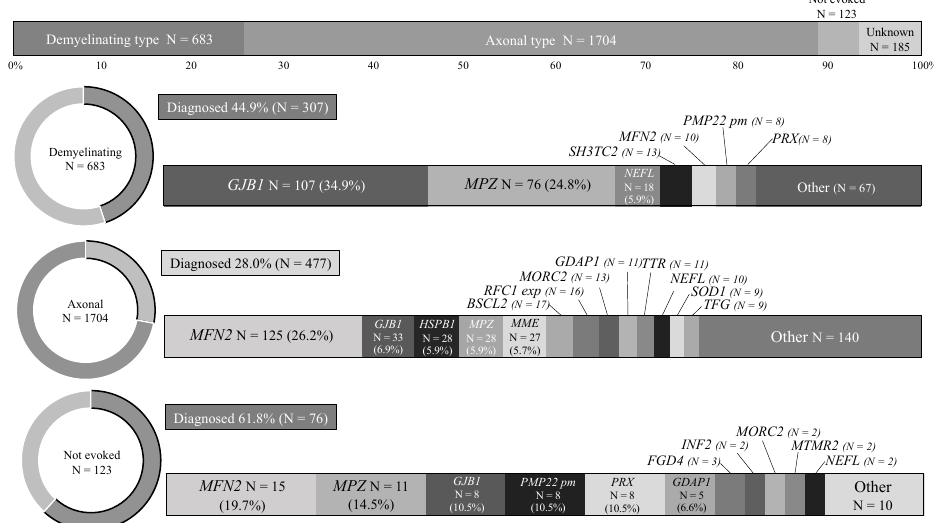
Figure 4. Diagnostic rate and genetic spectrum of IPNs with demyelinating, axonal, and not evoked subtypes. pm: point mutation.